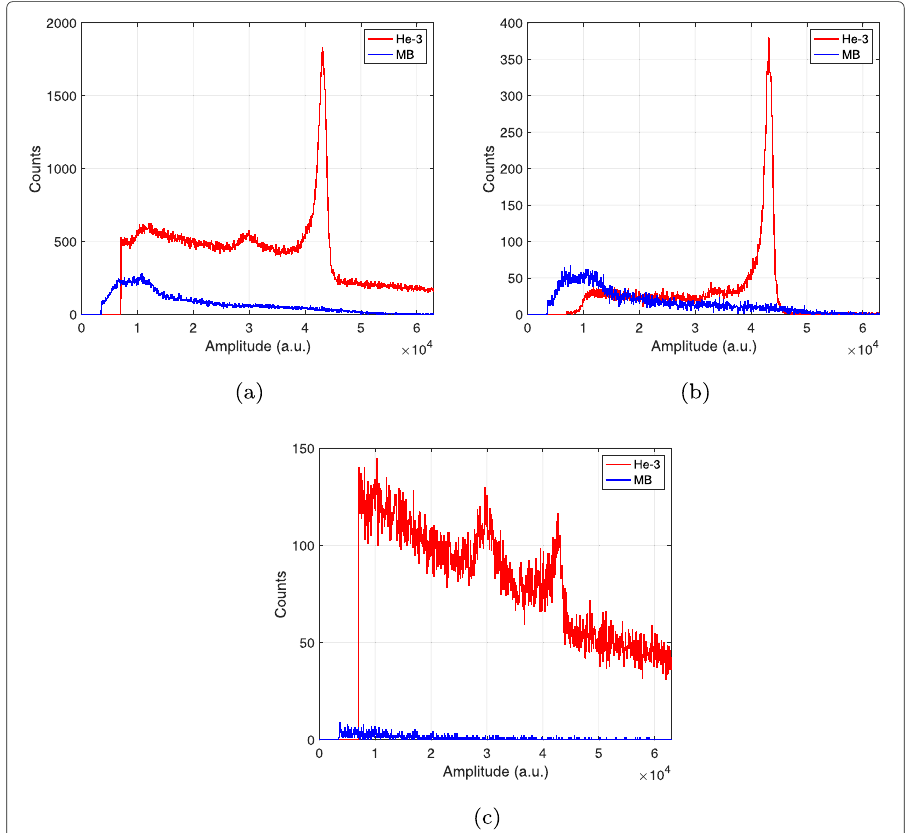
Fig. 18 a PHS in the full time window 200 ms, b PHS in ToF = 0 − 200 ms (chopper O) and c PHS in ToF